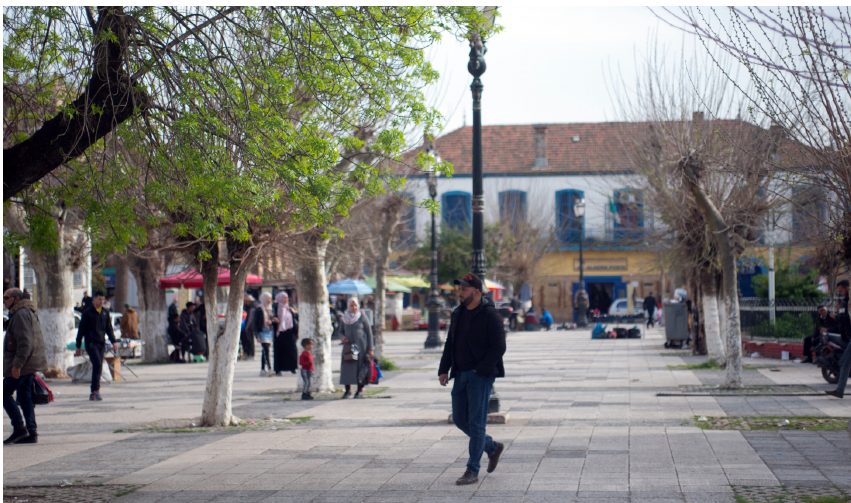
Fig. 7. November 1st 1954 Square of Medea. Women’s presence in the public place is lower than that of men. Source: authors, March 2021.